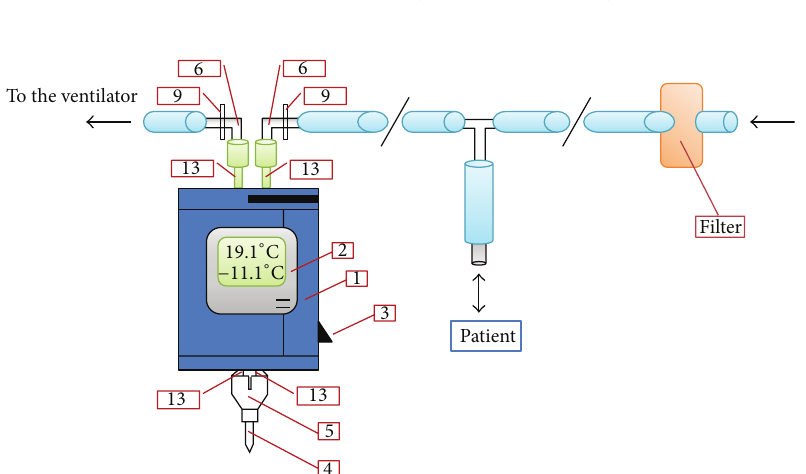
Figure 4: ANACON (Biostec, Valencia, Spain) condenser integrated in the mechanical ventilation circuit. The condenser is inserted in the expiratory branch of the ventilation circuit via 2 adaptors (9) and 2 elastomeric connectors (6). The exhaled air passes towards the condensation tubes (13) that pass through the body of the condenser (1). A Y piece (5) closes the circuit with the collection tube for the exhaled breath condensate (4). A thermometer (2) allows the condensation temperature to be monitored. The apparatus also contains a cooling switch (3) ( reproduced with permission from